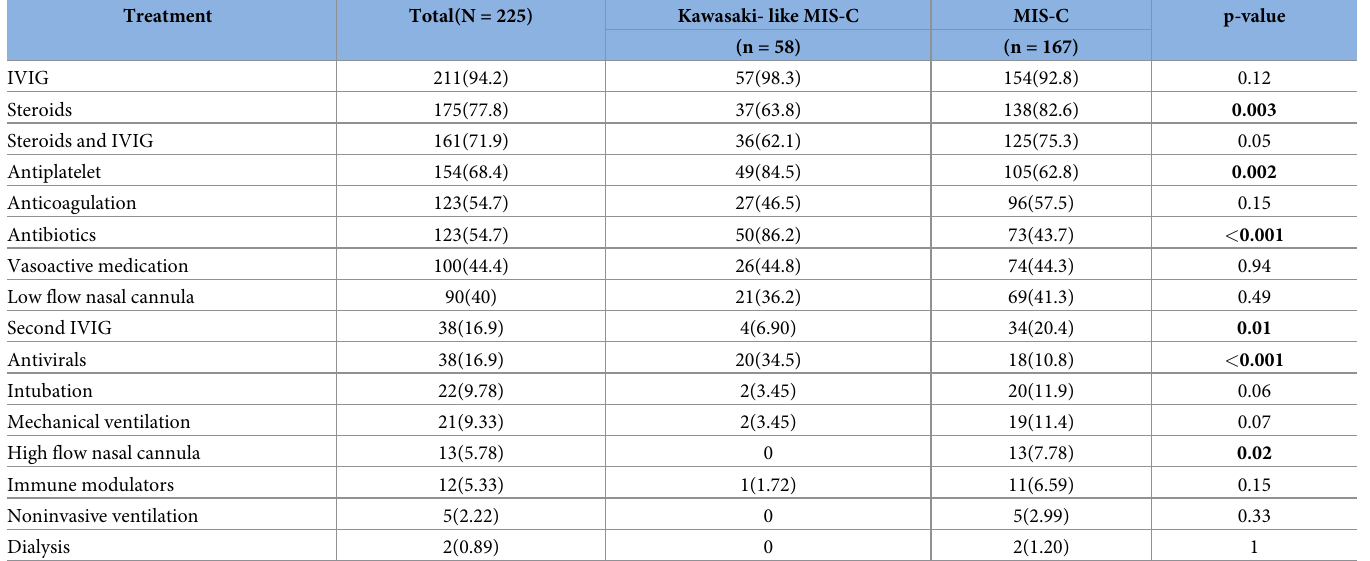
Table 4. Treatment in Kawasaki- like MIS-C and MIS-C